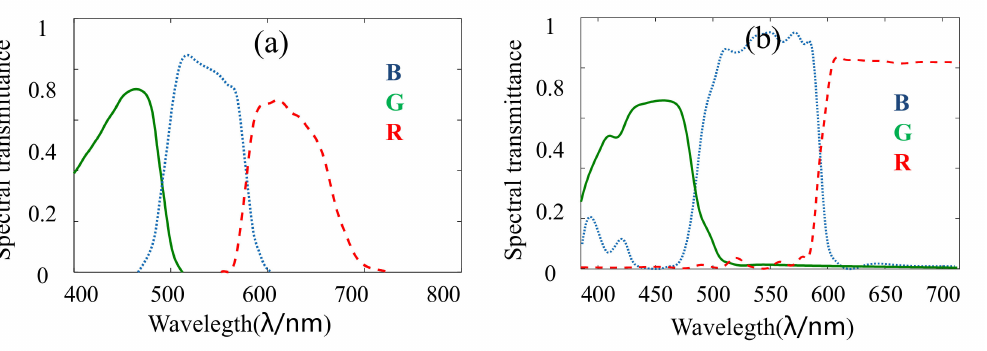
Figure 5. The difference in transmittance between common prism spectral structure and the newly designed prism spectral structure: ( a ) the spectral transmittance of common prism spectral structure; ( b ) the spectral transmittance of newly designed prism spectral